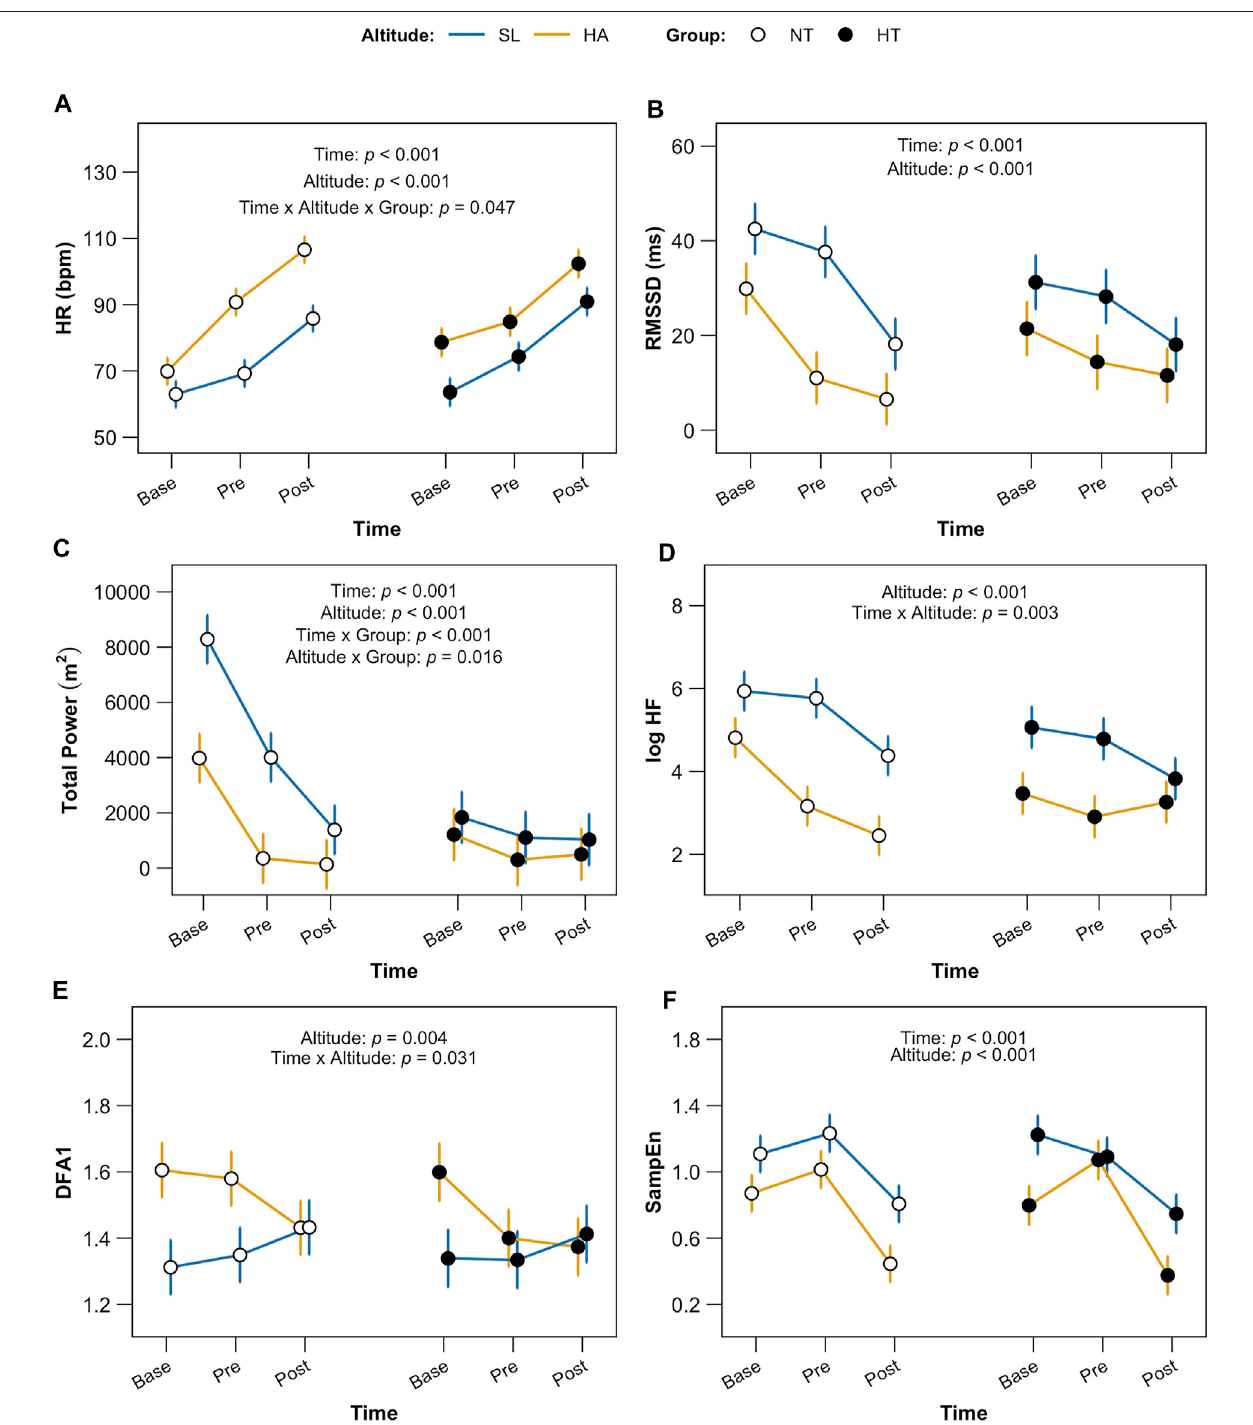
FIGURE 5 | HRV indices. Data are displayed per each time point (baseline, morning upon awakening, supine; pre, before 6MWT sitting; post, after 6MWT, sitting) for both groups (NT and HT) at both altitude (HA and SL). Panel (A) shows HR (heart rate); statistical signi fi cance: factors time and altitude p < 0.001, time x altitude x group p = 0.047. Panel (B) shows RMSSD (rootmean squareof successive differencesbetween normal heartbeats), an index of vagal tone in time domain; factors time and altitude: p < 0.001. Panel (C) shows TP (total power spectrum density); factors time and altitude: p < 0.001, group p = 0.007; time x groups p < 0.001 and altitude x group p = 0.016. Panel (D) shows logHF (High Frequency power), index of vagal out fl ow and RSA in frequency domain, altitude p < 0.001, time x altitude p = 0.003.Panel (E) displaysDFA1 (detrended fl uctuationalpha1), indexofvagal-sympathetic balanceinnon-lineardomain, altitude p =0.004and time xaltitude p =0.031 and Panel (F) shows SampEn (Sample Entropy), factors time and altitude p < 0.001.